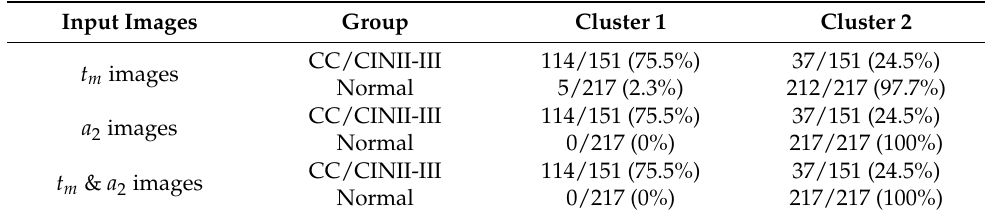
Table 2. Results of clustering of cell images in the training dataset.